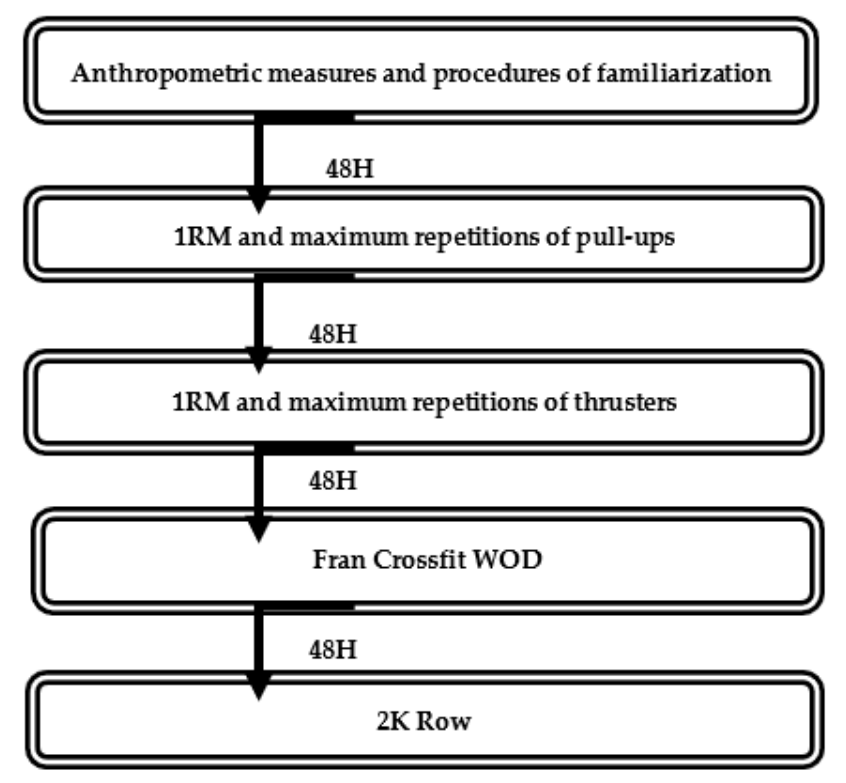
Figure 1. Experimental study design.